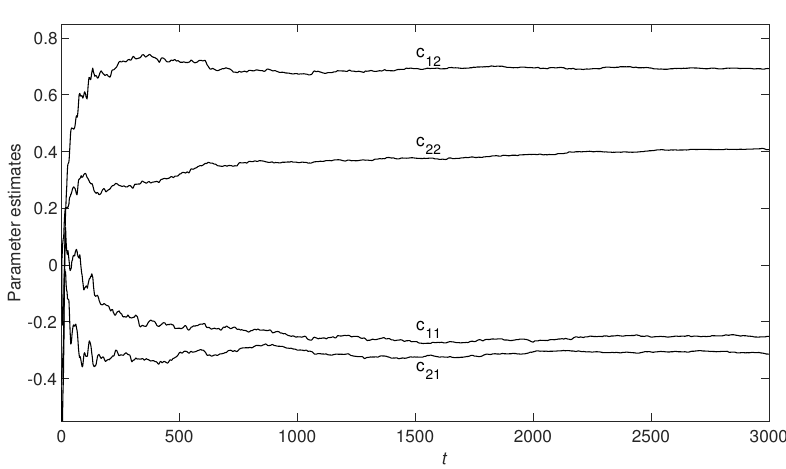
Figure 4. Parameter estimates ˆ c 11 ( t ) , ˆ c 12 ( t ) , ˆ c 21 ( t ) , ˆ c 22 ( t ) versus t